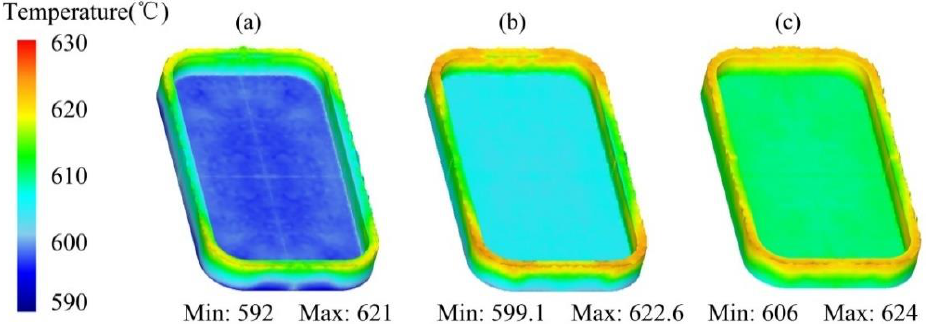
Figure 11. Temperature distribution of the mobile phone shell at the mould temperatures of ( a ) 350, ( b ) 400, and ( c ) 450 °C.